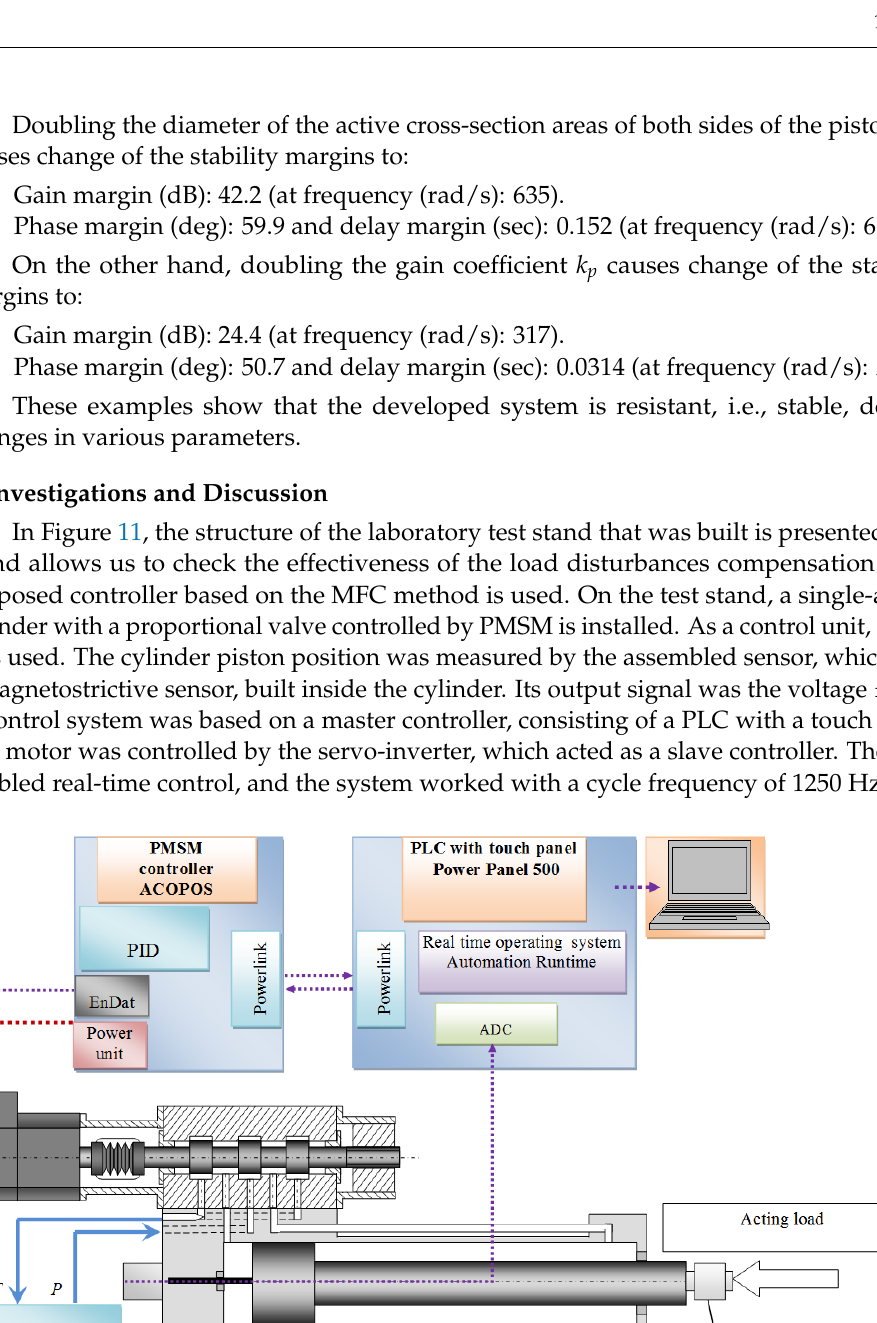
Figure 12. Test stand view. The model of the drive is implemented in the model loop of the MFC controller (Figure 13). The software implemented on the PLC control enabled to switch between a PID and MFC controller. In the design of the control system, the rapid prototyping tech- nique for the control system design is used. In this approach, the model of the control system has been built previously in the software environment and improved. After ob- taining positive test results, it was recompiled for the C code and then implemented as one of the task classes in the PLC. Because the used industrial controller PLC worked in a discrete mode, it was necessary to discretize the continuous model of the control system. The discrete time base was established as T = 0.8 ms. This value resulted from the mini- mum time base for a single task execution on the PLC controller.